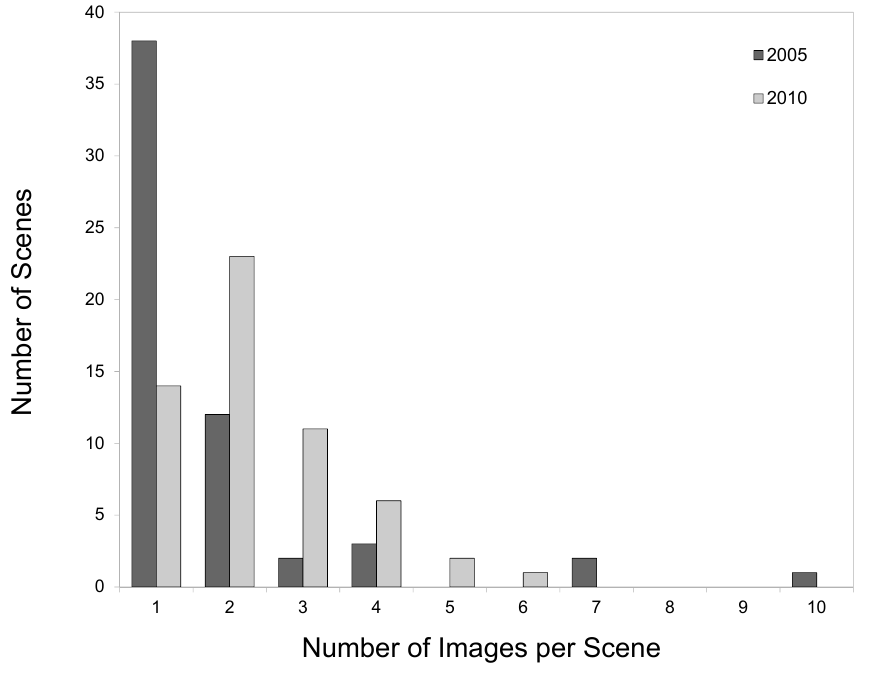
Figure 6. The number of images composited per scene for 2005 and 2010 composite mosaics. Note the high proportion of scenes requiring three or fewer images. Also note the decreasing proportion of scenes requiring only a single image between 2005 and 2010. This indicates that even though areas of peat swamp forest cover of interest occupy smaller proportions of scenes in 2010 and would potentially require fewer images to be mapped, this is offset by additional missing area due to the SLC-Off